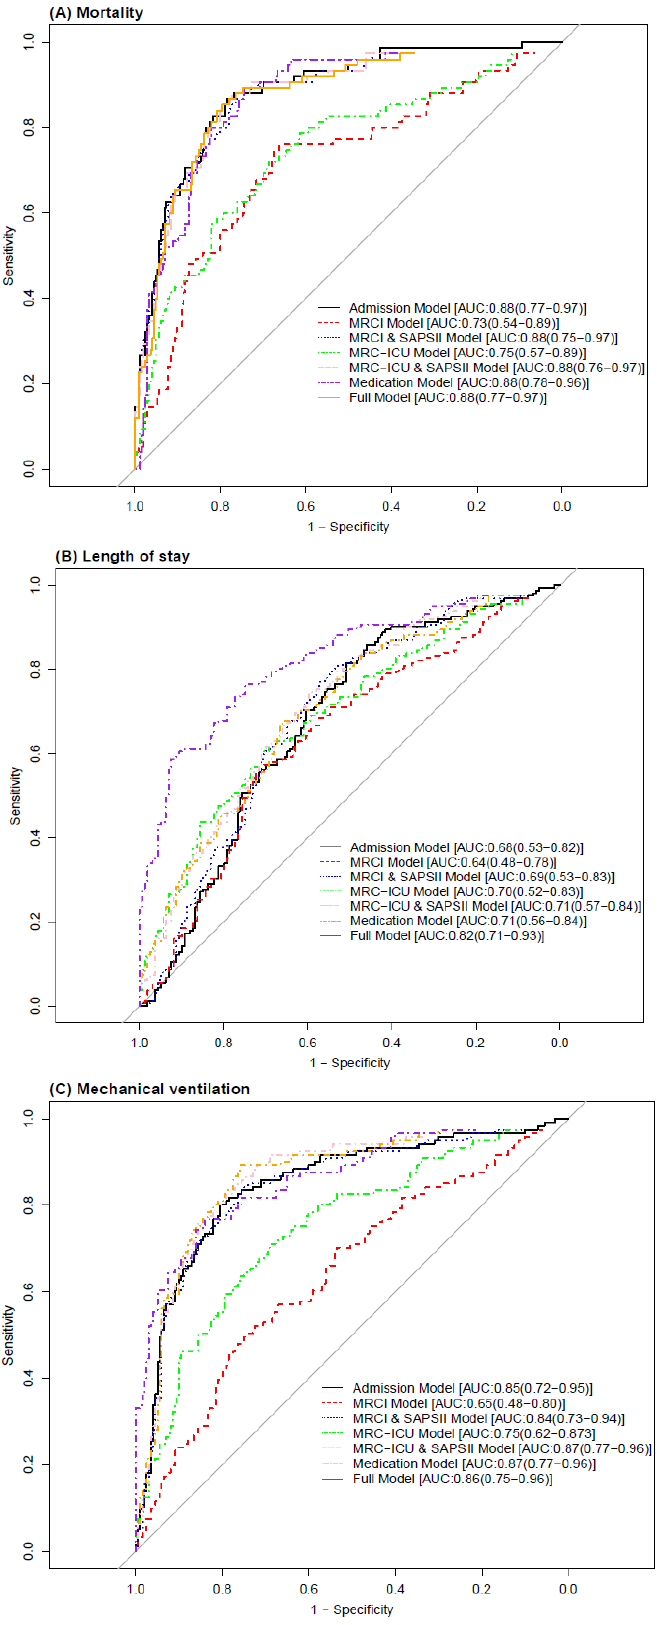
Figure 2. Performance of the prediction models for predicting the clinical outcomes. Receiver operating characteristic curves (AUCs) for ( A ) ICU mortality, ( B ) ICU length of stay, and ( C ) need for mechanical ventilation.